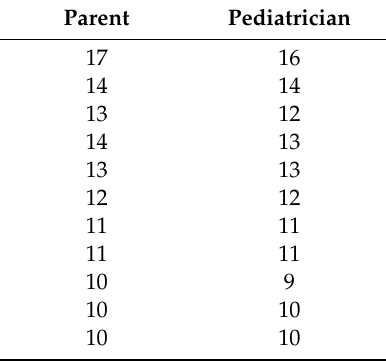
Table 3. Individual CoMiSS by parent or pediatrician with a positive score in the Spanish cohort. Parent